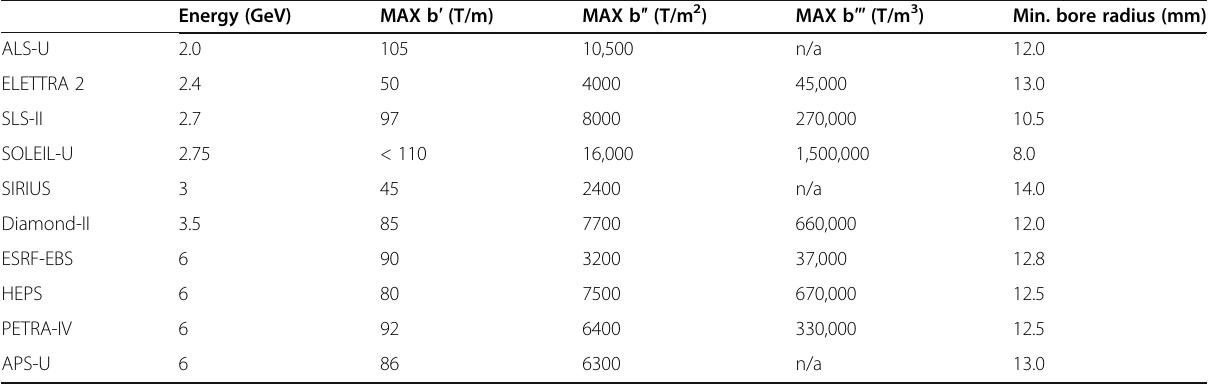
Table 2 Magnet field summary for 4GSR